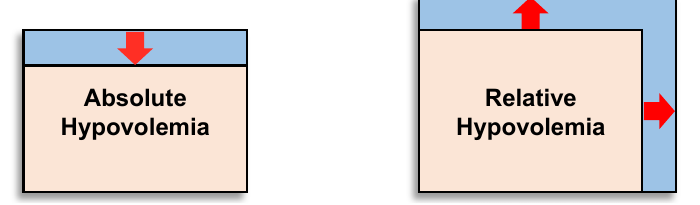
Figure 1. Illustration of the concept of absolute and relative hypovolemia. Pink represents the vascular (blood) volume and blue represents the vascular space. Absolute hypovolemia (reduction in blood/plasma volume) can be mediated by factors such as hemorrhage or dehydration; relative hypovolemia can be mediated by factors that increase vascular space such as increased cutaneous vasodilation from heat stress, hypoxia, intense physical exercise, or systemic vasodilation from sepsis. Image modified from [15].